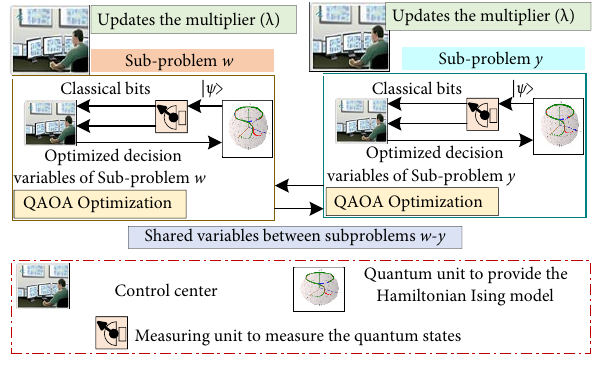
Fig. 5 Schematic of distributed optimization of power